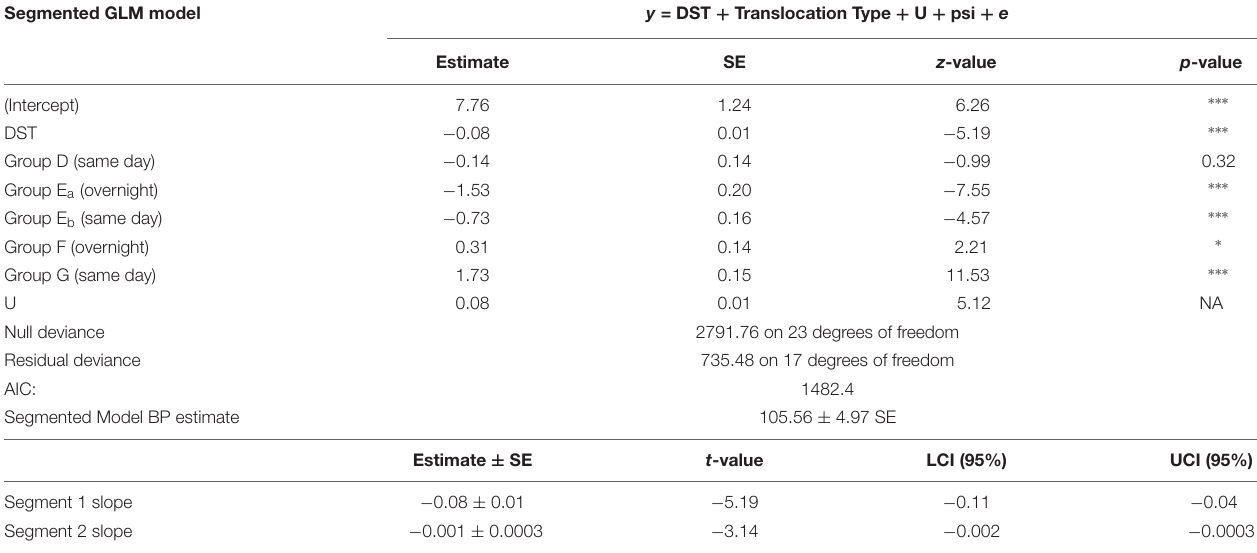
TABLE 3 | Segmented generalized linear model (GLM) results and breaking point estimate for coral group survivorship over time. Segmented GLM